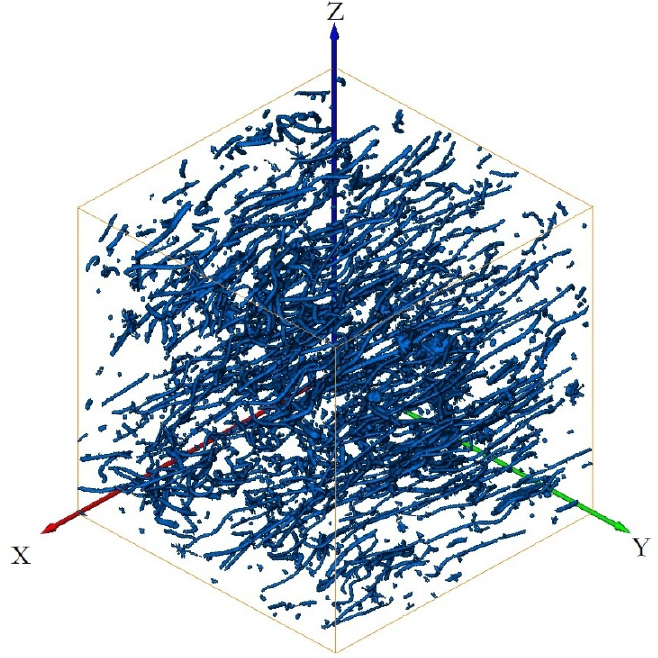
Figure 16. Avizo software reconstructs the polyester short fiber image for the third time.